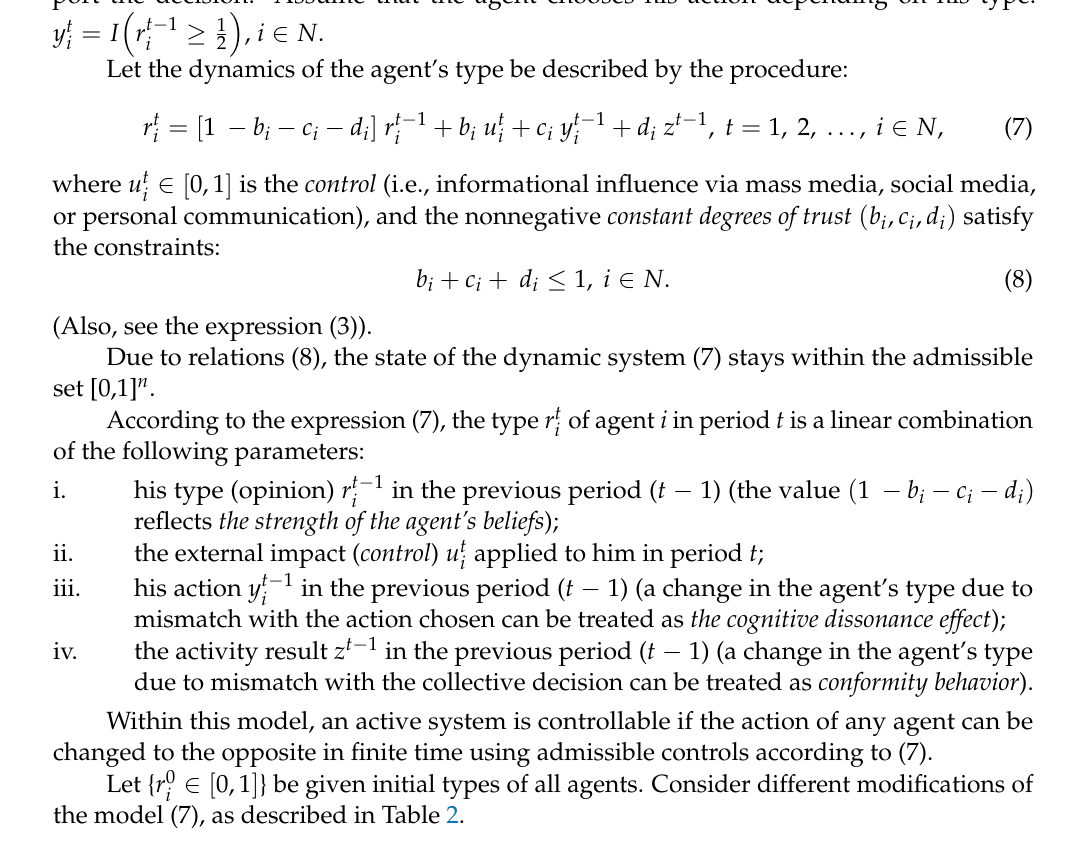
Table 2. Modifications of model